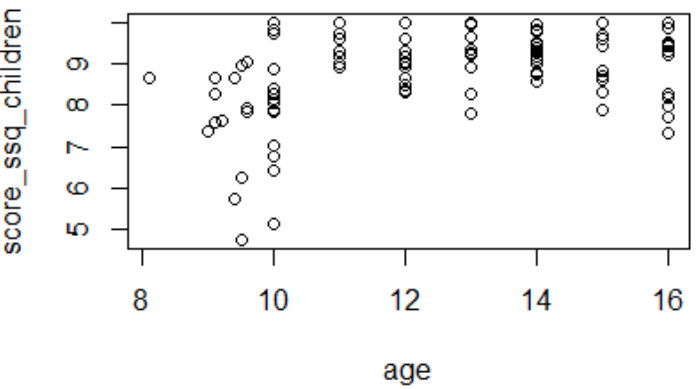
302 ( b ) Figure 1. Boxplots of SSQ for children and for parents total scores in normal-hearing and hearing- impaired children. ( a ): SSQ children questionnaire; ( b ): SSQ score parents questionnaire. Supplementary Materials File S4 shows the discriminant validity of the SSQ score for the different subscales. Discriminant validity was also confirmed at the level of subscales. 3.5. Analysis of the Impact of Age of Children on Answers No significant was found for the questionnaire filled in by parents. In fact, the corre-